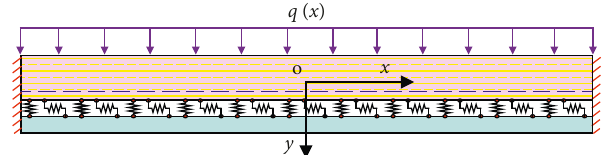
Figure 15: The mechanical model of double-layer rock